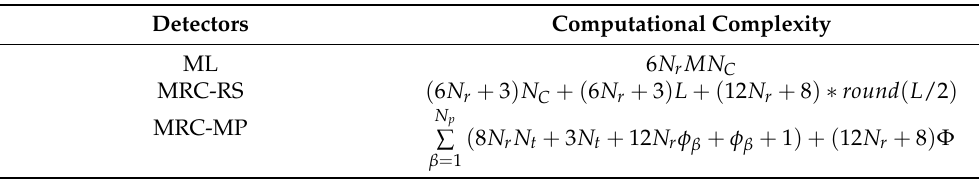
Table 4. Comparison of above-mentioned detectors for the M-PSK constellation.